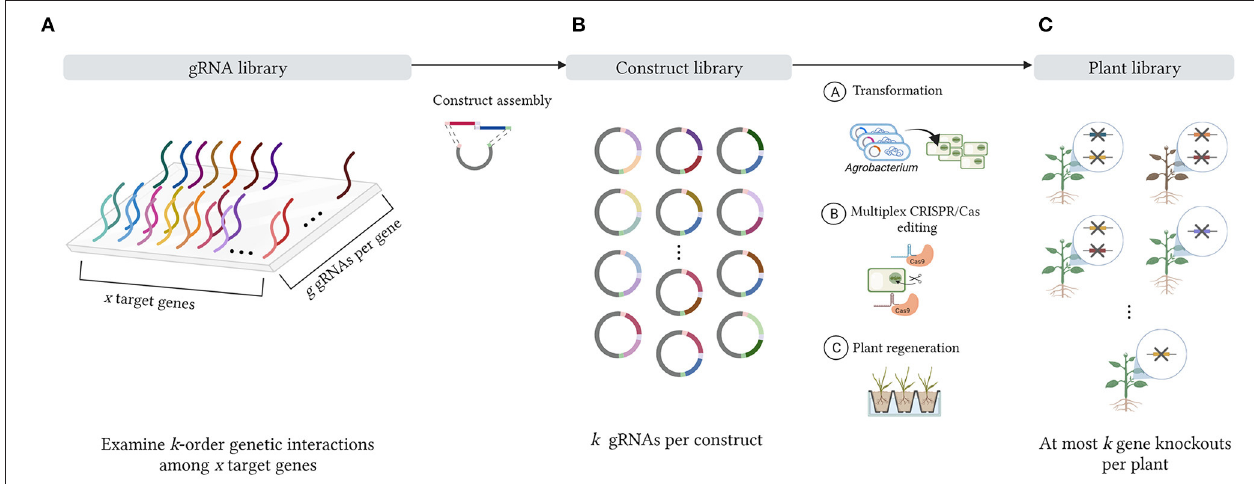
FIGURE 1 | Schematic representation of a multiplex CRISPR/Cas experiment. (A) First, x target genes are selected for CRISPR/Cas editing. A number of g gRNAs are designed for each target gene, forming an initial gRNA library. (B) During vector assembly, gRNA sequences from the gRNA pool are randomly combined into a combinatorial gRNA/Cas construct library with k gRNA sequences per vector to study the effects of k -combinations of gene knockouts, i.e., k -order genetic interactions among the set of x target genes. After transformation of the combinatorial gRNA/Cas constructs into the target cells, the gRNA/Cas complexes can be expressed, leading to genome editing of the associated target loci. (C) After plant regeneration, a diverse mutant plant collection is obtained with at most k gene knockouts per plant, forming the plant